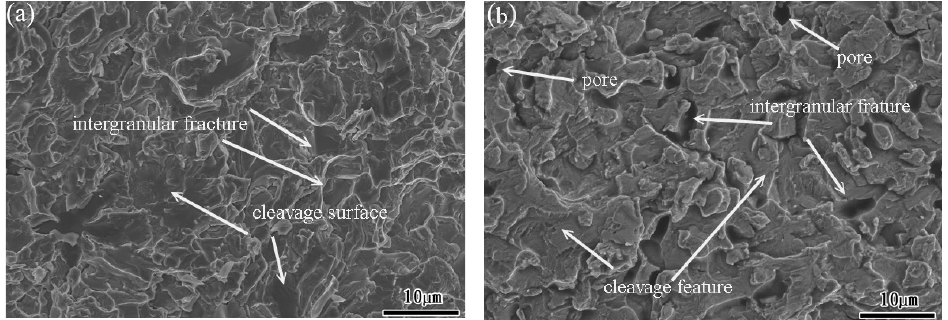
Figure 10. Fracture surface morphology of TiNi 44 Nb 2 alloy under ( a ) static deformation conditions, and ( b ) dynamic deformation conditions (2000× magnification).